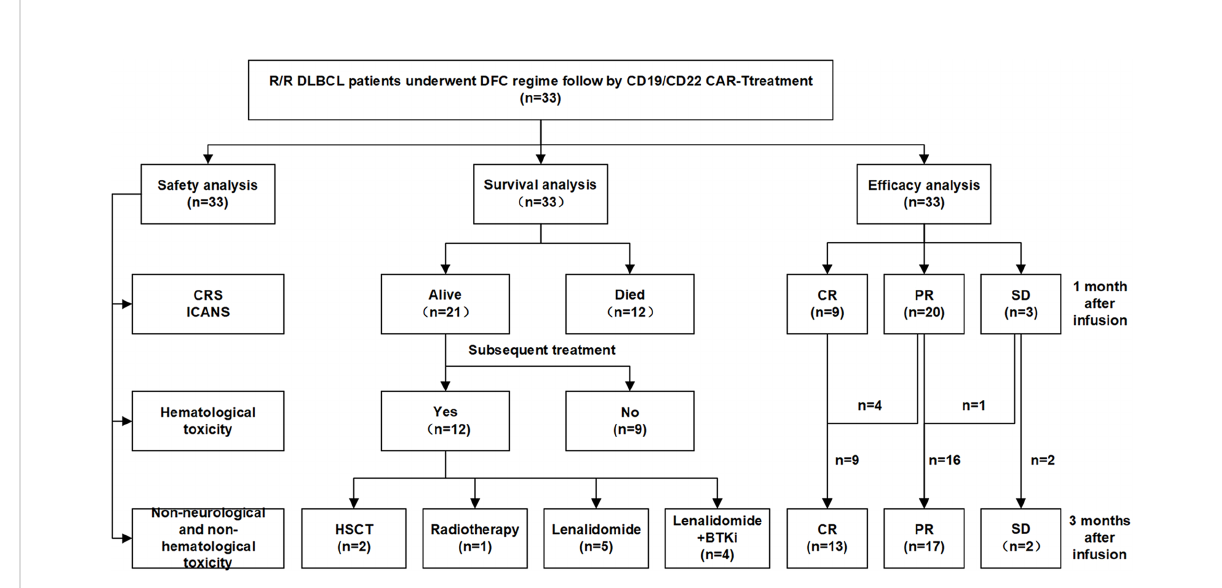
FIGURE 1 Flow chart of treatments of the enrolled 33 R/R DLBCL patients.